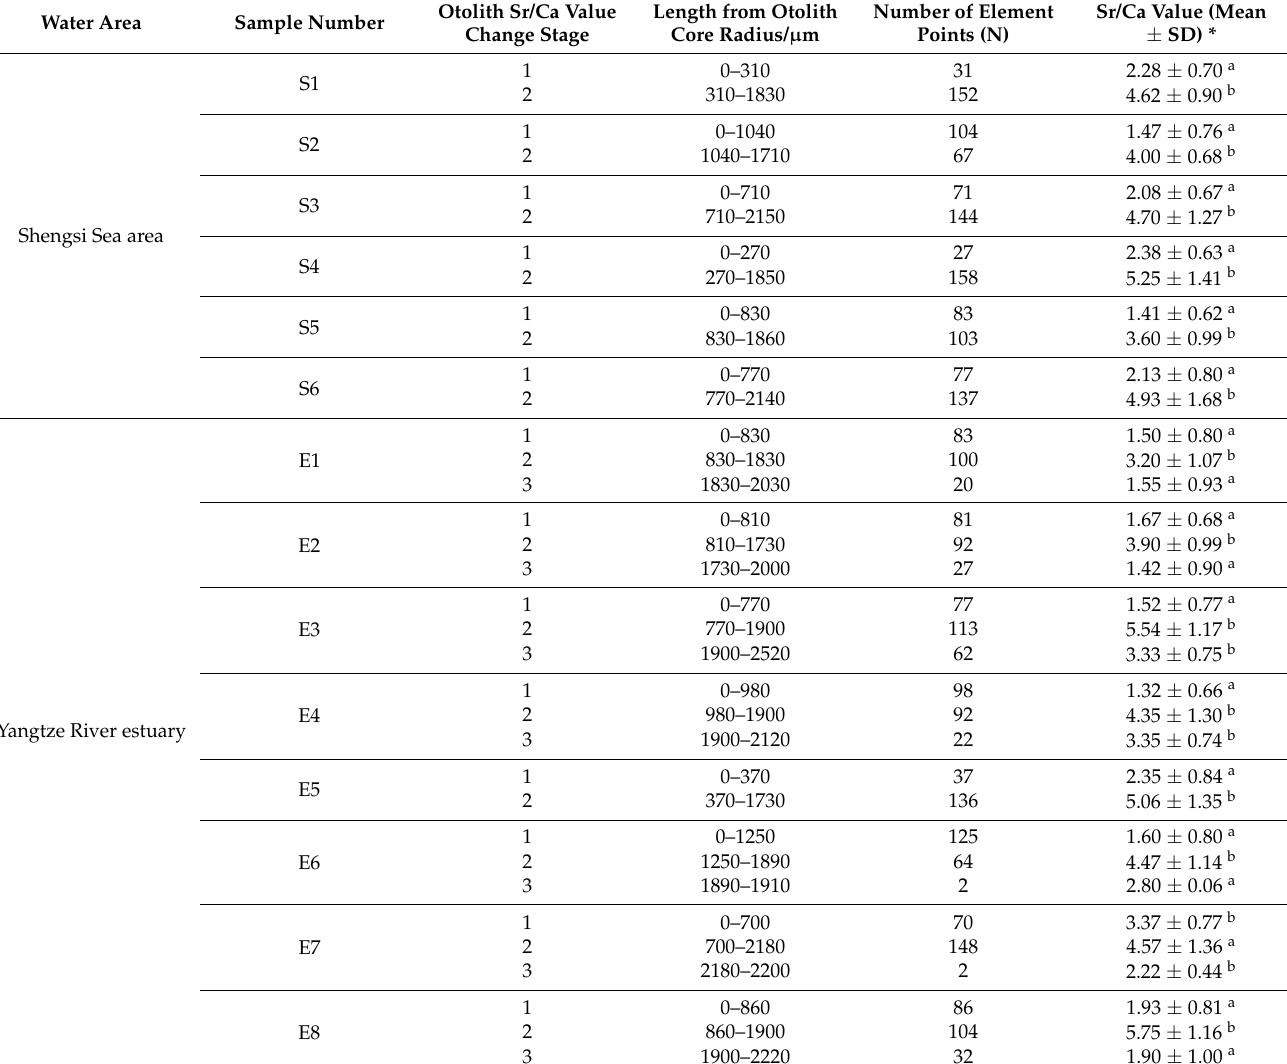
Table 3. Change in Sr/Ca value in otolith of C. nasus in different water